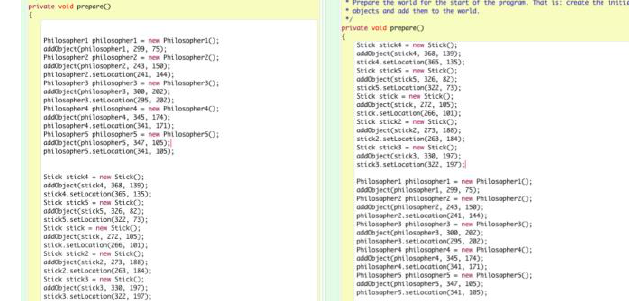
Fig. 3 Different sequence of actors positioning on Greenfoot